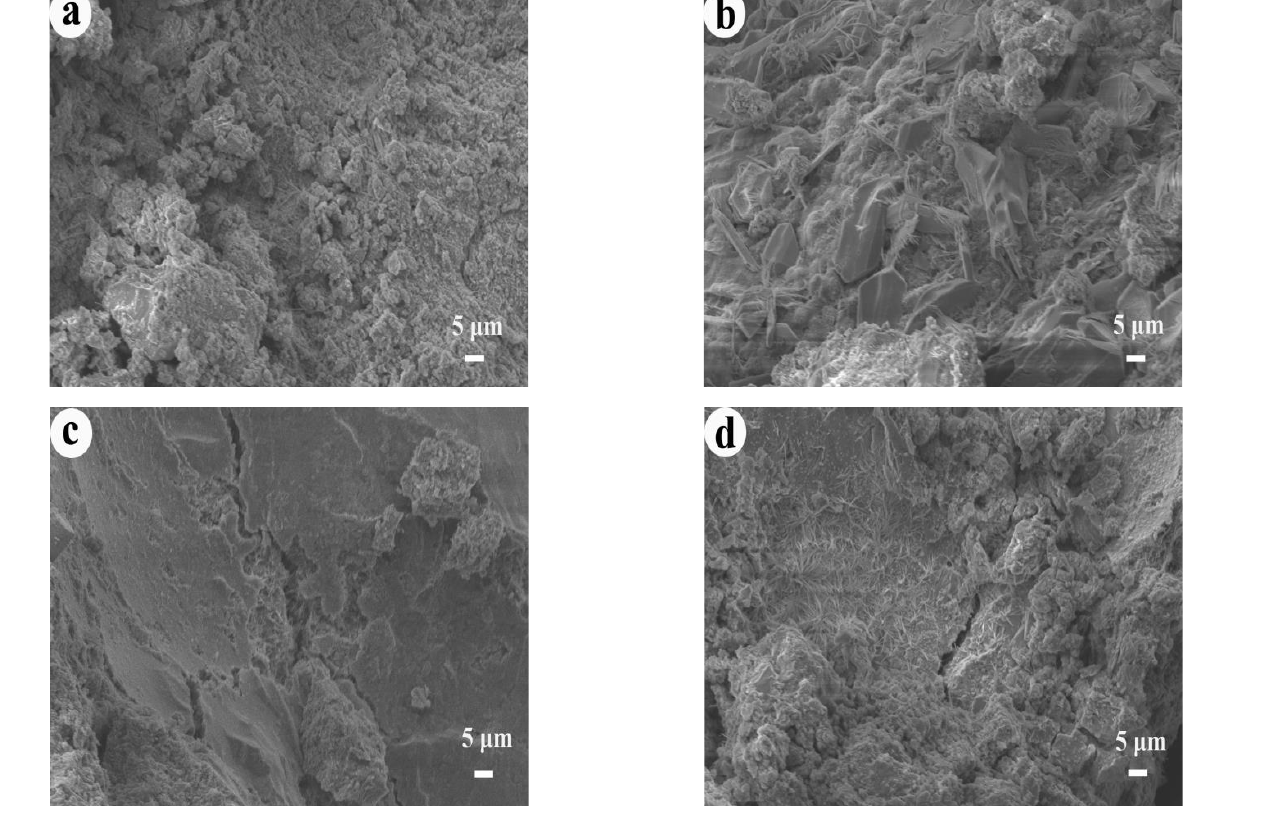
Figure 10. SEM images of mortars: ( a ) RT, ( b ) T40, ( c ) T60, ( d )